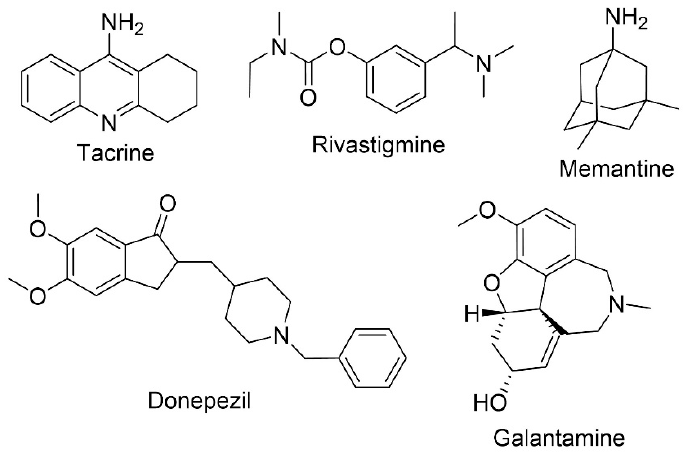
Figure 3. Chemical structures of the approved therapies for AD, tacrine, rivastigmine, memantine, donepezil, and galantamine.